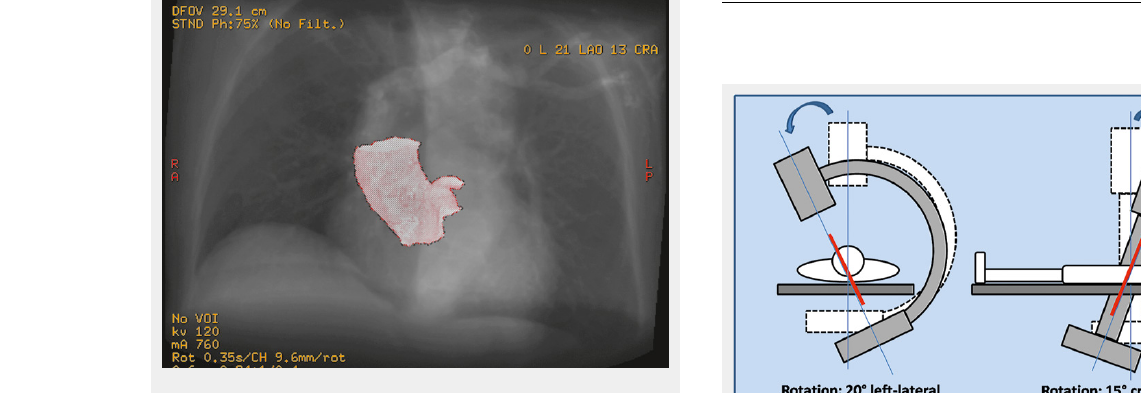
A schematic view of the fluoroscopy orientation in the operating room. The left-lateral and the cranial orientations are calculated preoperatively using CT-scan